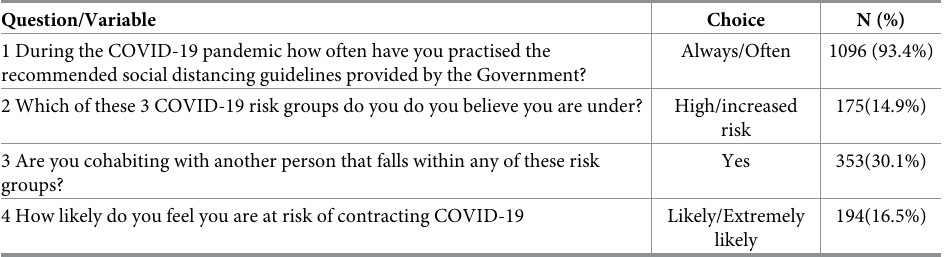
Table 4. Covid related questions for descriptive analysis.